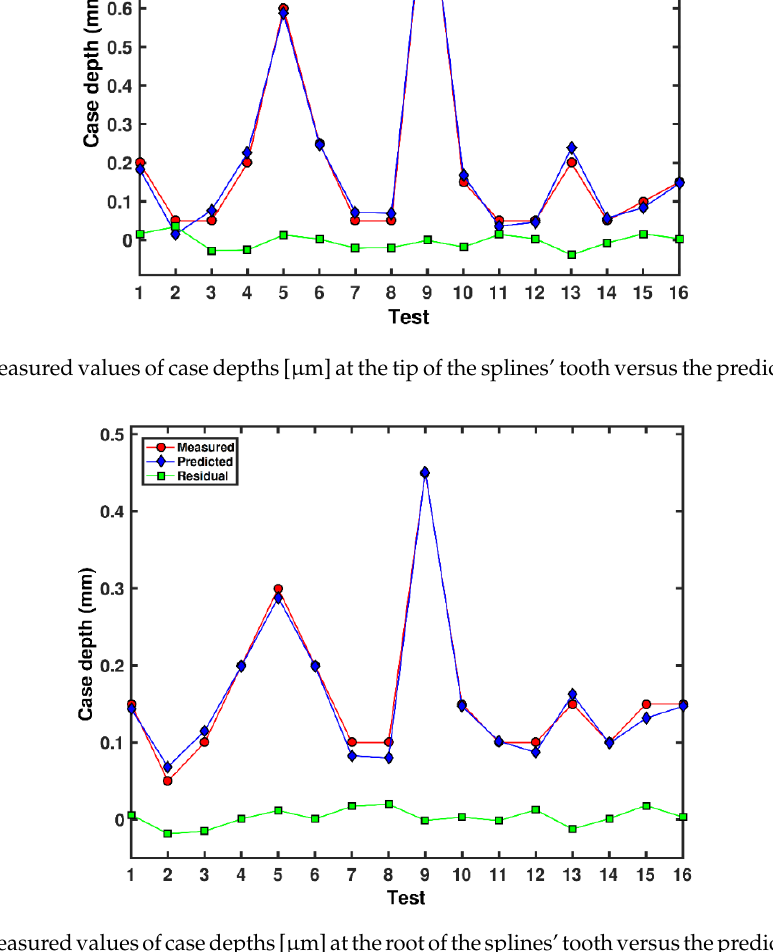
Figure 7. Measured values of case depths [µm] at the root of the splines ’ tooth versus the predicted values.